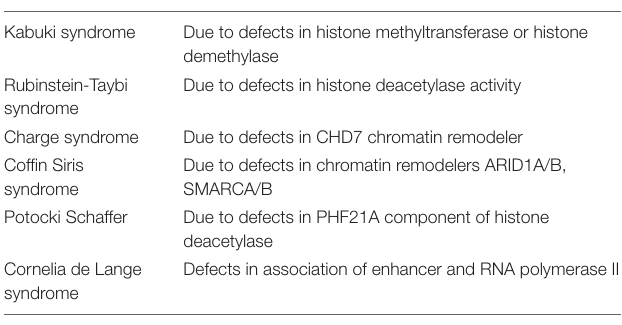
TABLE 3 | Enhancer functions and